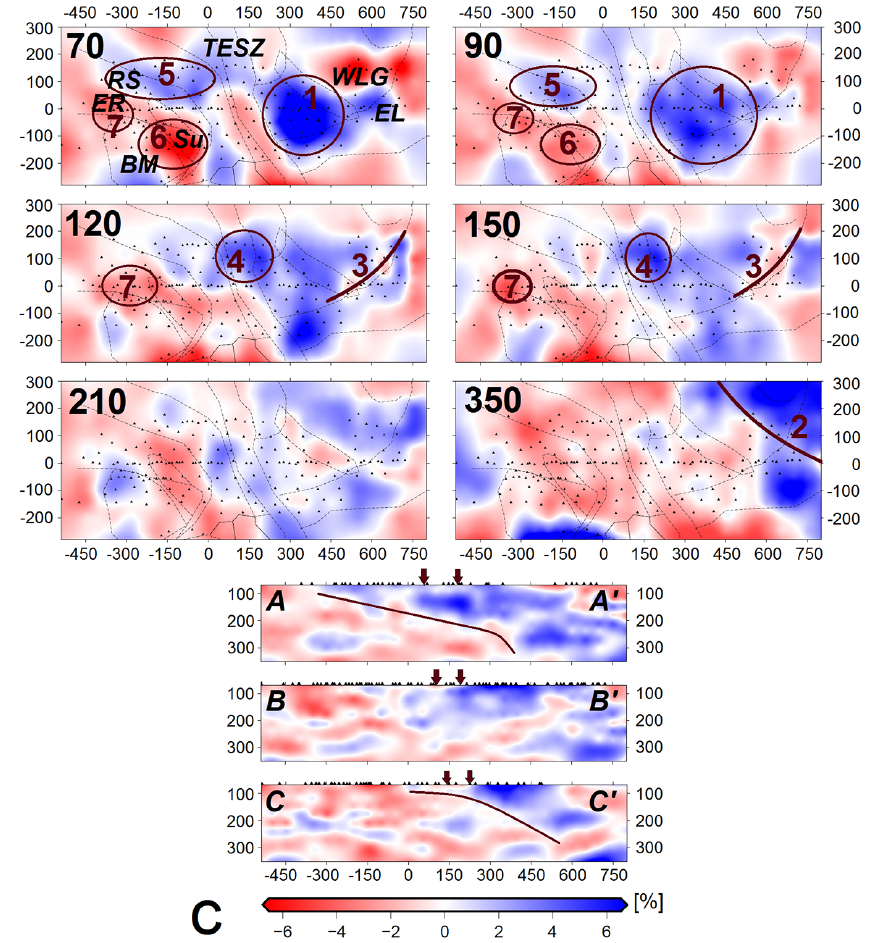
Figure 9. P wave velocity perturbations in horizontal slices at indicated depths (km) and vertical slices parallel to the main transect of the study area. Results obtained with the synthetic “geological” model: (a) input velocity model, and (b) inversion results. (c) Results obtained with the field data set. Triangles mark seismic stations. x , y and z indicate longitude, latitude and depth (km), respectively, in a local Cartesian coordinate system. Dashed lines on horizontal slices indicate boundaries of tectonic units (see Fig. 1b). Numbered areas mark the discussed interpreted structures: (1) high-velocity area beneath Poland (craton); (2) deep cratonic roots extending to at least 300km or more beneath Lithuania; (3) paleosubduction boundary between the WLG and the EL; (4) high-velocity area beneath northern Poland; (5) higher velocity area along the Rheic Suture; (6) lower velocity area beneath the Sudetes Mountains and the Bohemian Massif; (7) low-velocity area beneath the Eger Rift. Solid lines on vertical slices show the interpreted seismic LAB; and brown arrows indicate the